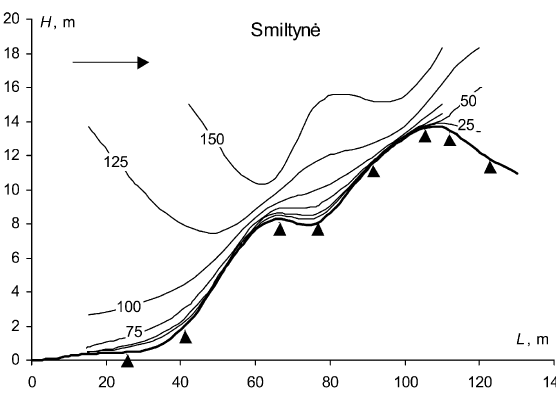
Fig. 5. Variations in wind speed (%) in the cross-shore profile near Smiltyn ė .